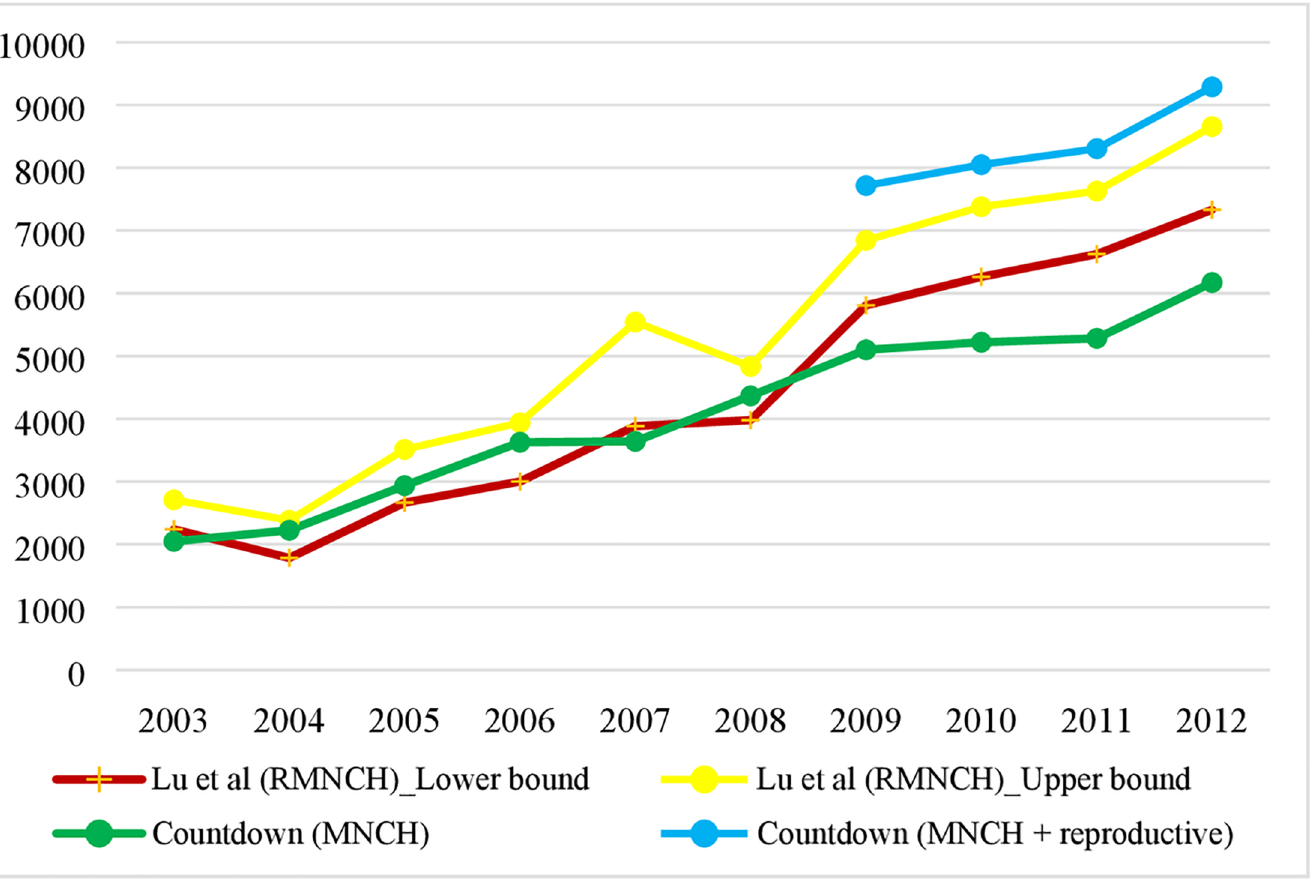
Fig 6. Comparison of estimateson RMNCH in the 74 Countdown countries in 2012 USD.